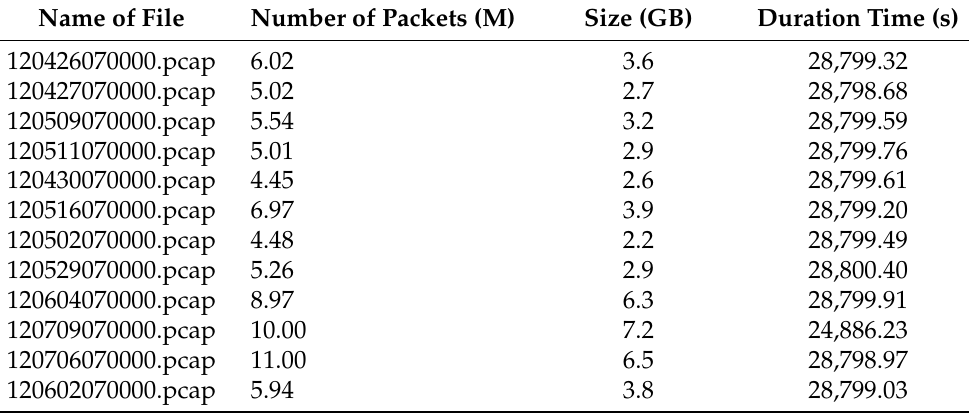
Table 1. Cleansed network dumps from UAN-12